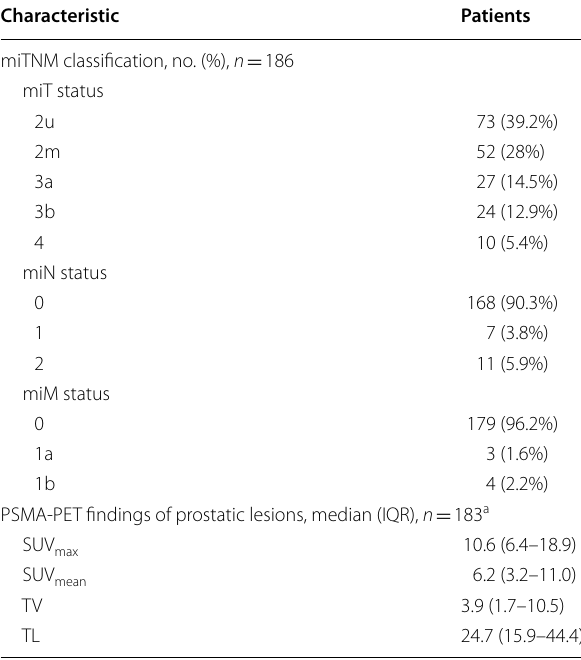
Table 3 68 Ga‑PSMA‑11 PET findings